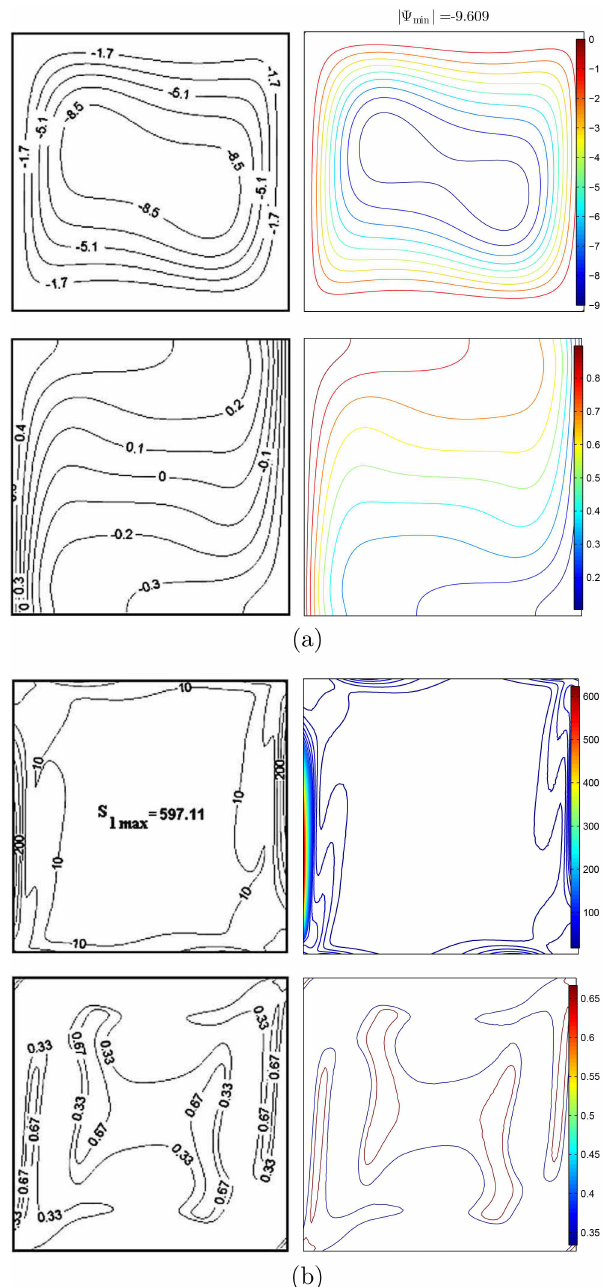
Figure 3. Comparison of the field patterns with literature work of Ilis et al. [47] ( left ), current study ( right ), when Ra = 10 5 and φ = 0; ( a ) the streamlines and isotherm contours and ( b ) the global entropy generation and Bejan